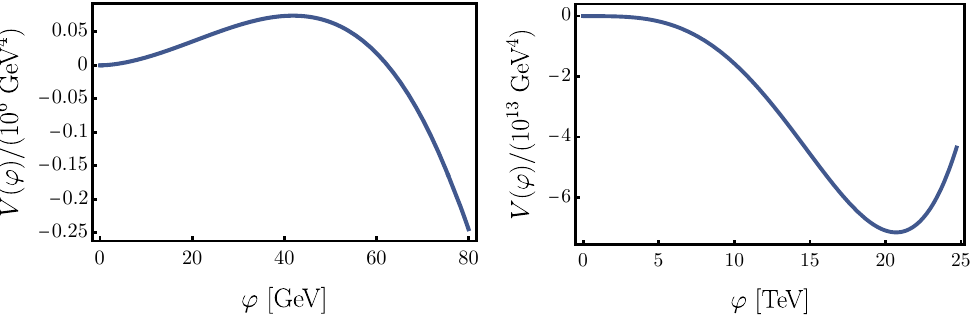
Figure 4 . RG-improved effective potential at nucleation temperature along the ϕ direction for a benchmark point with g = 0 . 9 , M = 10 4 GeV in two ranges of the field values — around the X X barrier, where the tunnelling takes place (left panel), and around the minimum (right